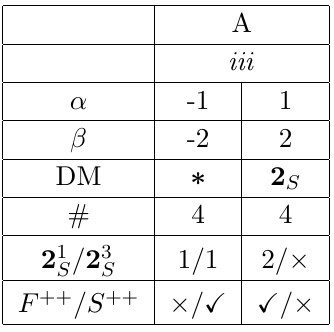
Table 25. The same as in table 24 for diagram